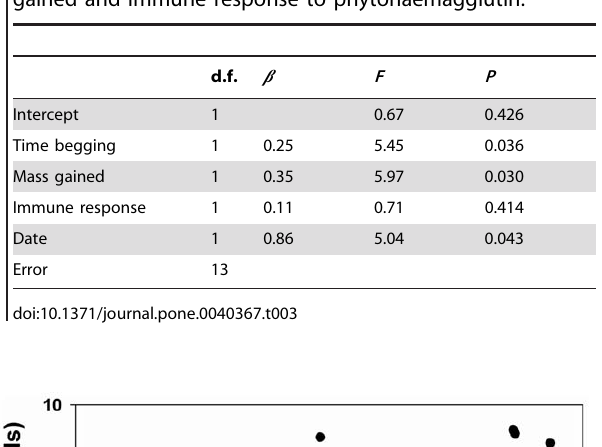
Table 3. Restricted Maximum Likelihood Estimation General Linear Mixed Model (REML-GLMM) showing the relationship between time begging and concentration of malondialdehyde (MDA) as indicator of damage caused by oxidative stress, controlling for nest (random), date, mass gained and immune response to phytohaemagglutin.